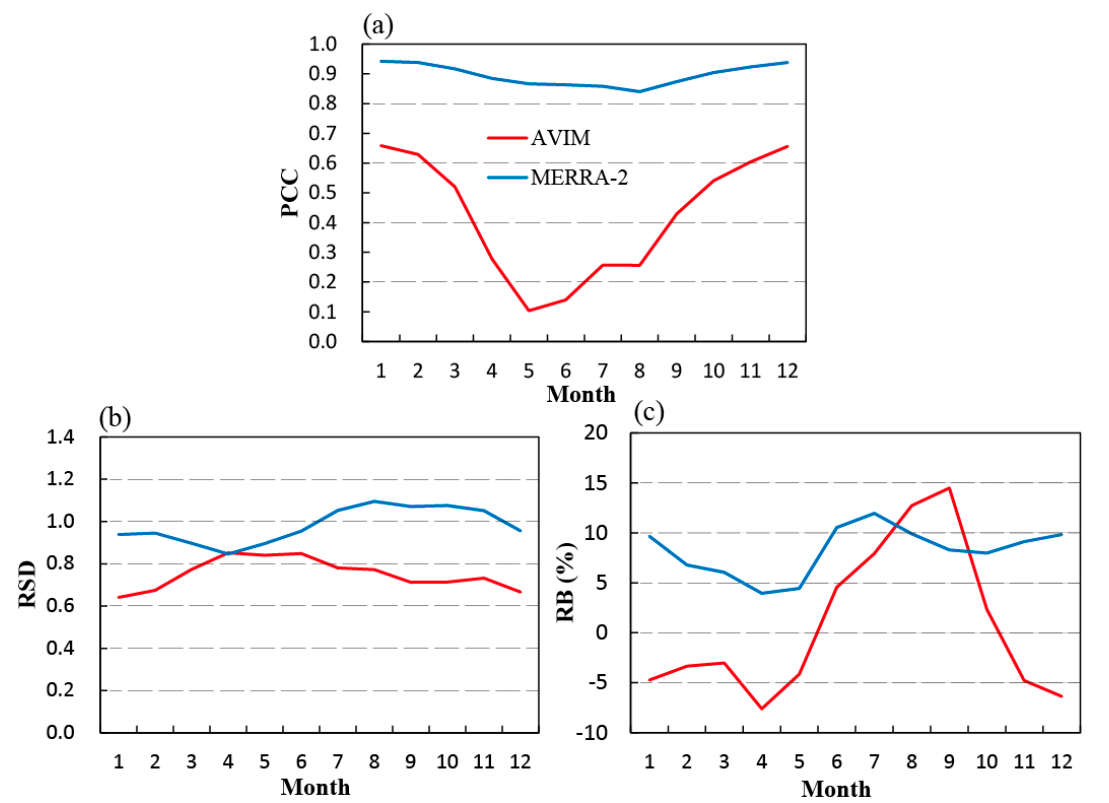
Figure 7. Monthly PCC ( a ), RSD ( b ), and RB ( c ) of the AVIM and MERRA-2 evapotranspiration with the GLEAM dataset as a reference. The statistics were calculated based on mean annual monthly global data.